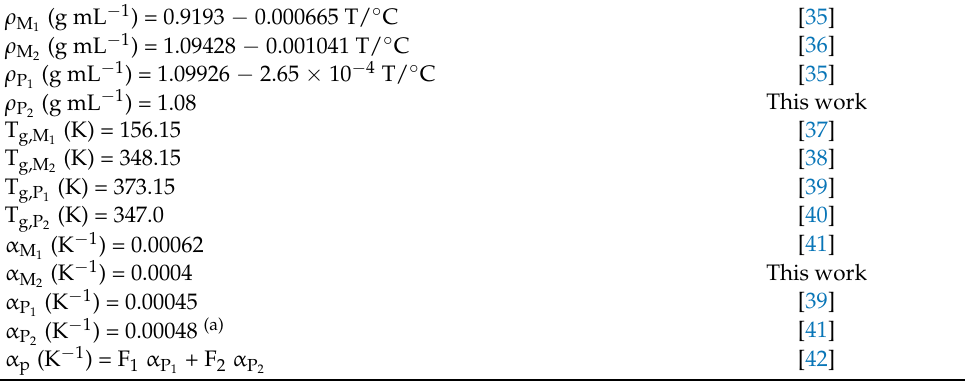
Table 6. Physical properties of monomers and polymer for calculation of fractional free volume.